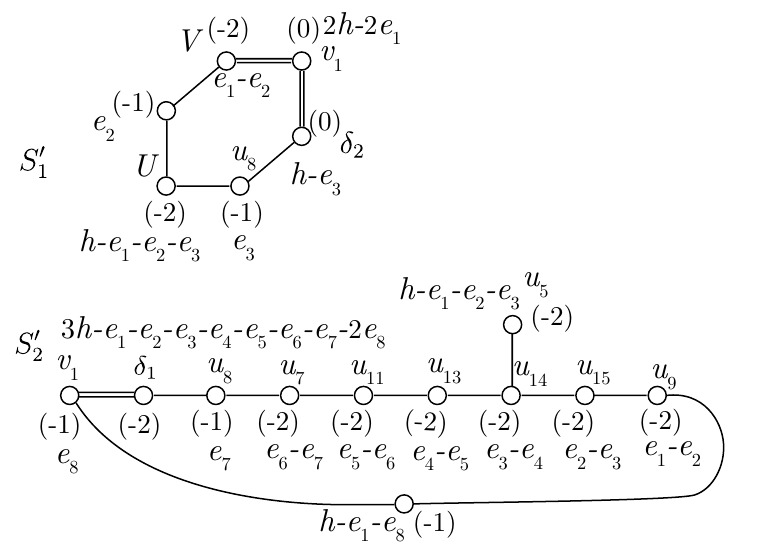
and S 0 in the (E 8 ; SU(2)) marginal geometry after 1 2